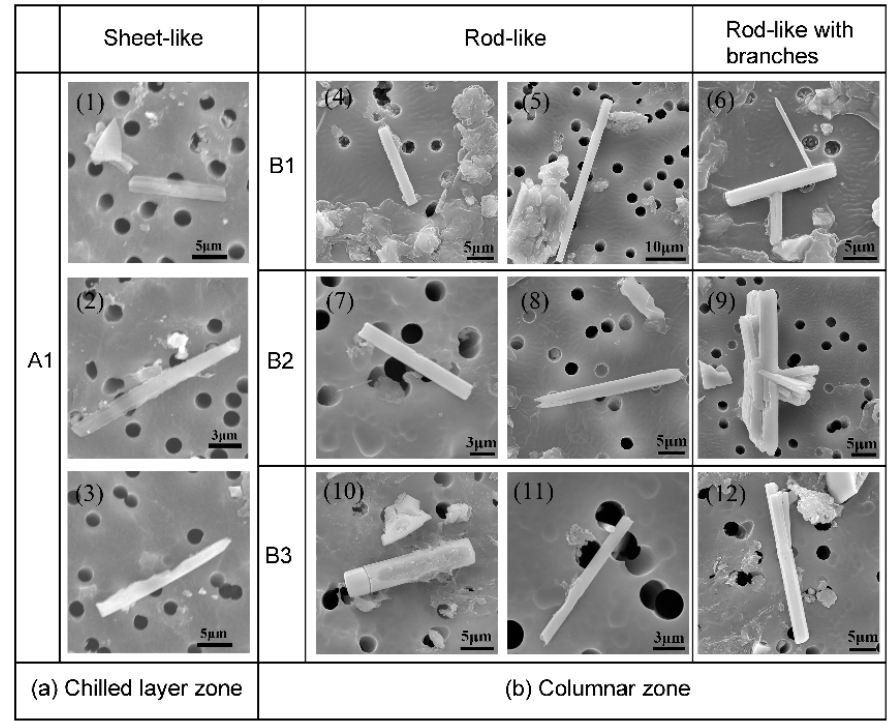
Figure 5. Typical morphologies of CaS inclusion in chilled layer zone ( a ) and columnar zone ( b ).